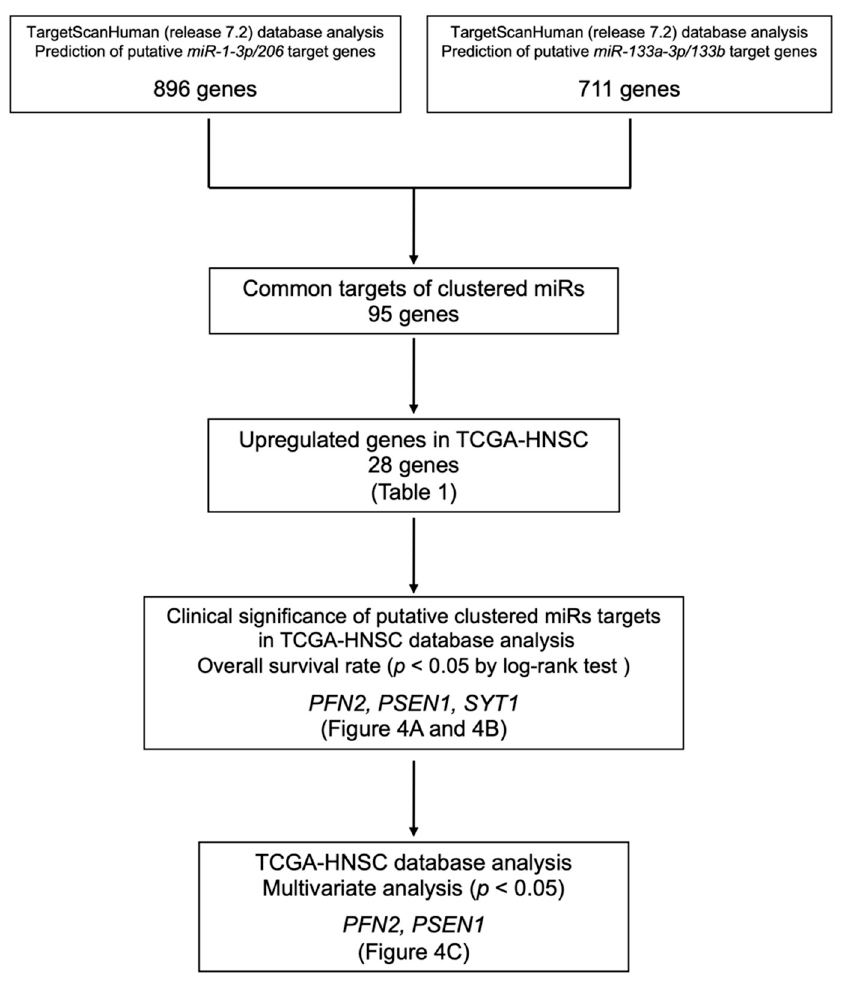
Figure 3. Our strategy of identification of miR-1 / miR-133 clustered miRNAs targets in HNSCC cells.